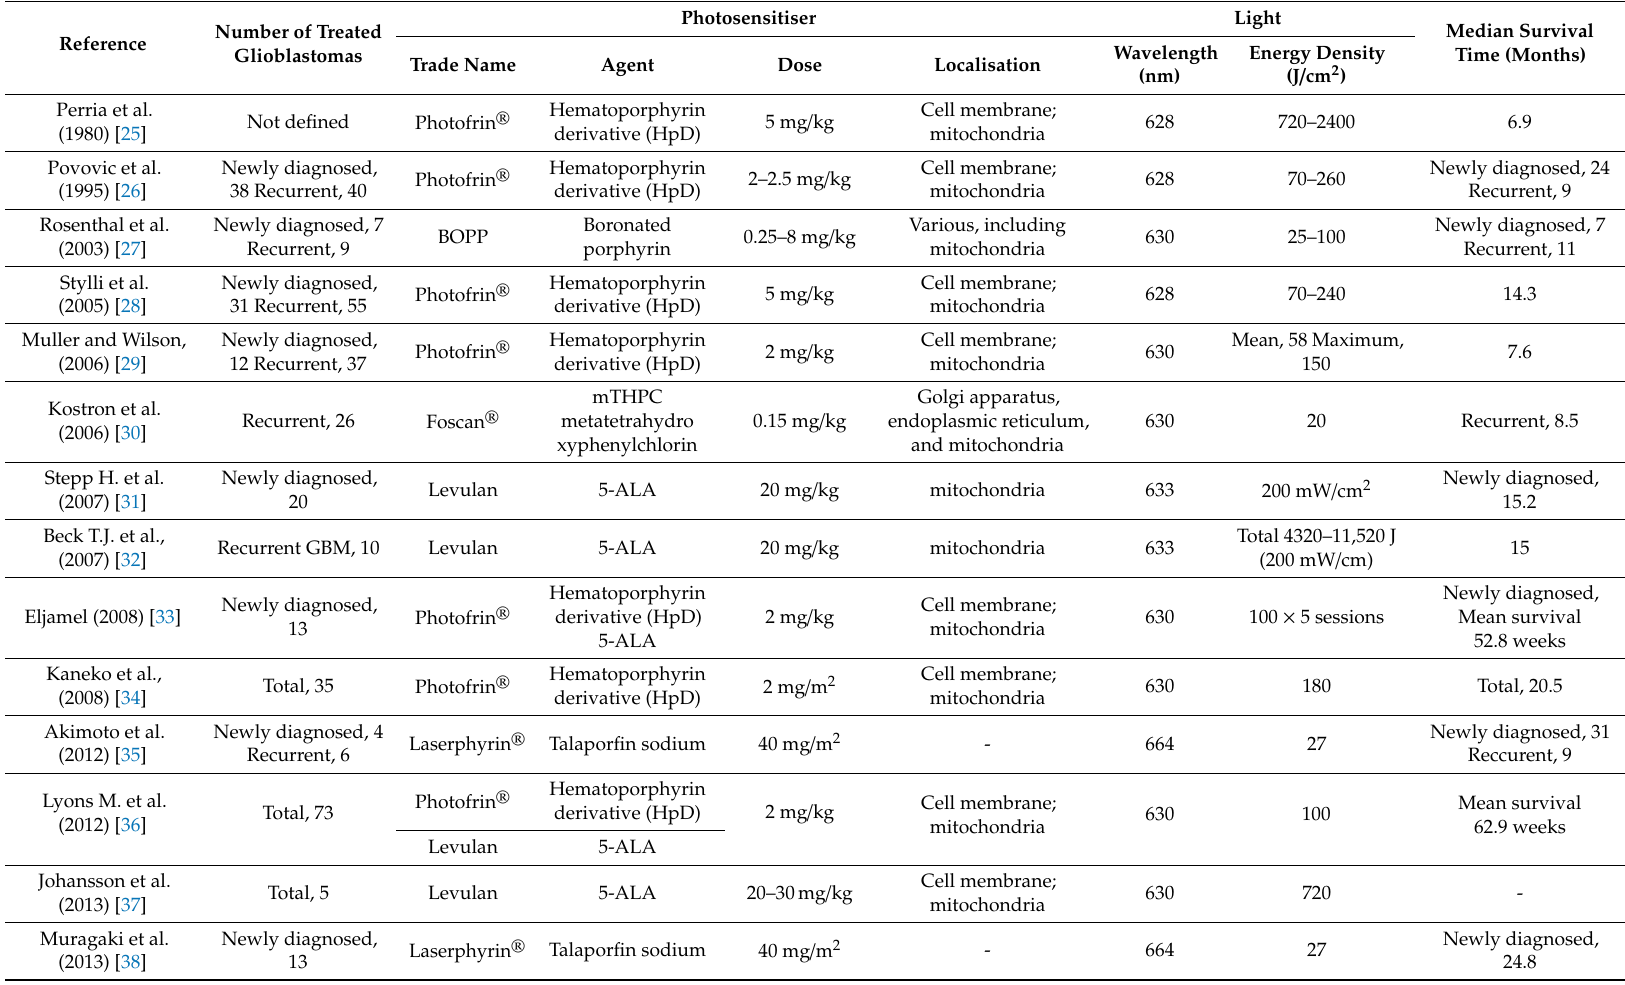
Table 1. A selection of in-vivo studies which utilised photodynamic therapy (PDT) for glioblastoma multiforme (GBM)